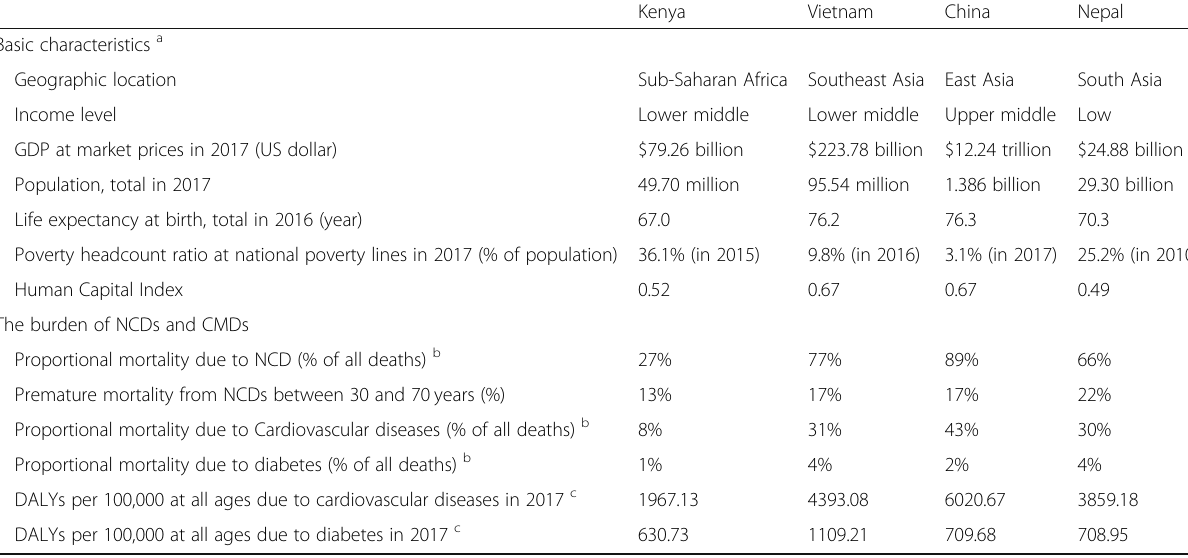
Table 2 Basic demographic and economic information of four countries in the